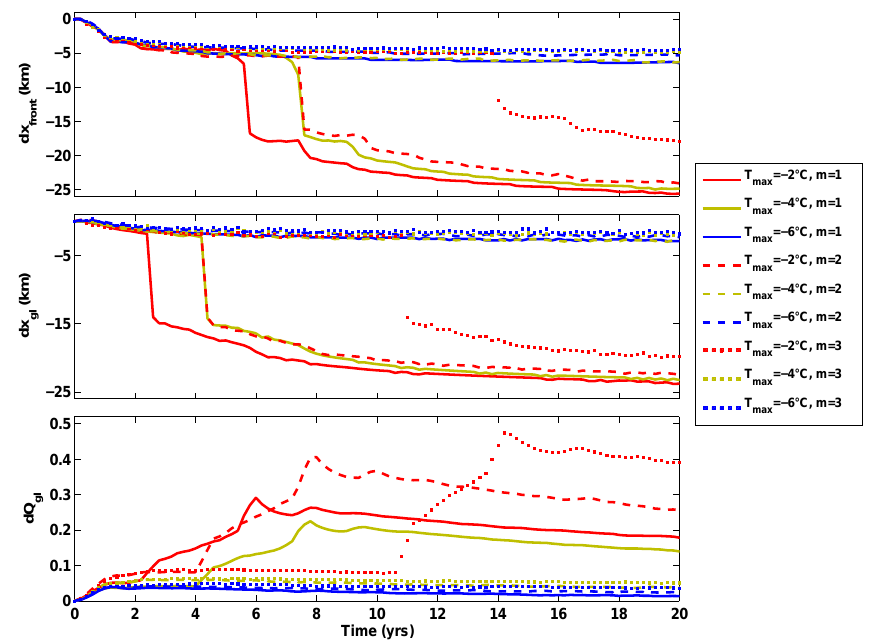
Fig. 8. Time series of (top panel) front position change, (middle panel) grounding line change, and (bottom panel) the fractional increase in grounding line discharge relative to the initial discharge for simulations performed using the over-deepened bed profile. As in Fig. 6, profiles are shown for the model simulations with enhanced ice deformation (i.e., E =